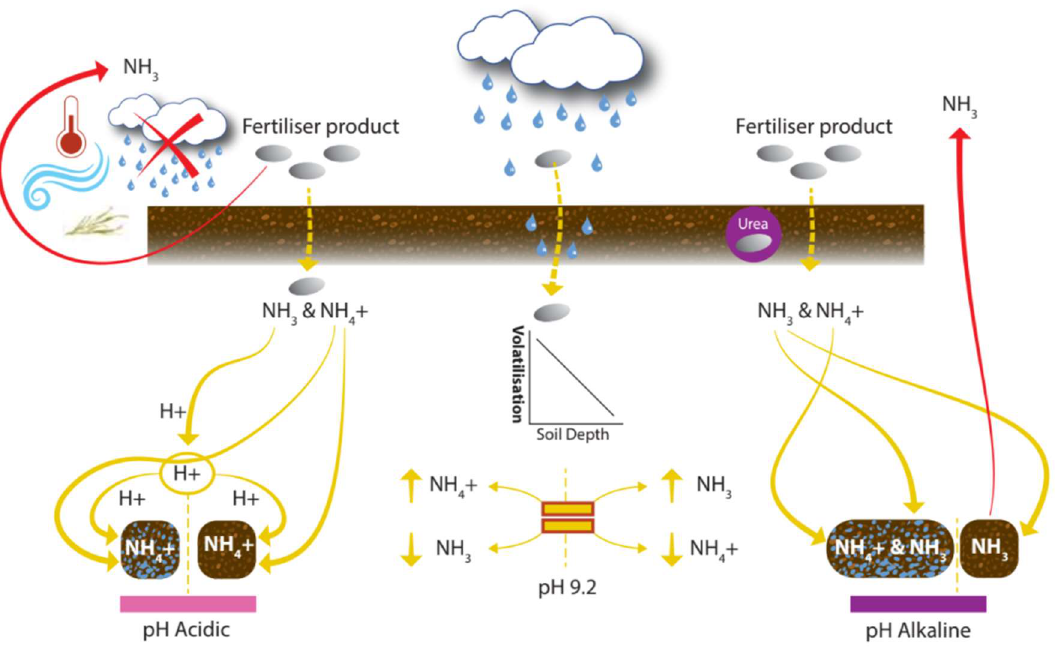
Figure 7. Control of volatilization losses from the soil–plant system. Icons show: temperature, wind, rainfall, and crop residue.